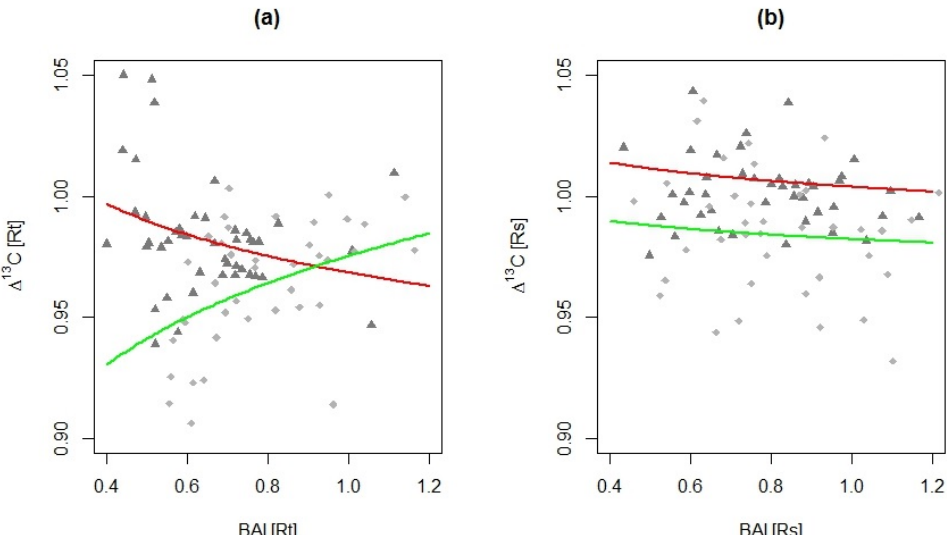
Figure 3. Relationship between the resistance ( a ) and resilience ( b ) of the Δ 13 C and BAI of spruce and beech trees in the drought year 2003 (lmer with logarithmic transformation of resistance (RT) and resilience (RS) in the model). Differences are significant between the species for the RT ( p < 0.01 **). Light grey circles represent the values of resistance or resilience in 2003 of beech trees, dark grey triangles represent those of spruce trees.